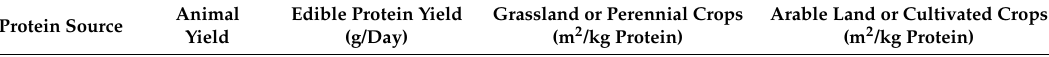
Table 9. Model calculations for the land use per kg edible protein depending on animal species/categories, plant yields, animal performances, and co-products from the agriculture, food, and fuel industries (see Tables 3–5 for further